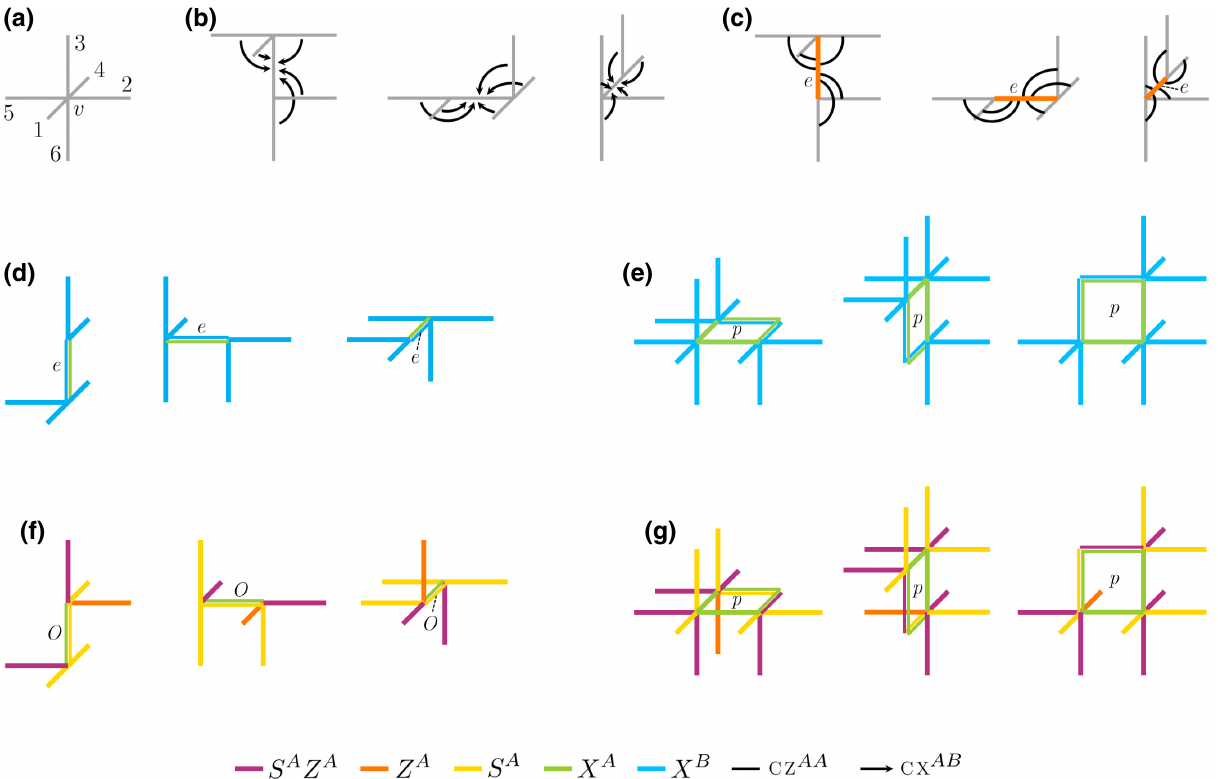
(cid:5) v U v . For a given edge, (cid:5) and (e) under U . (f) The operator ˆ F 0 , X A e e p e ∈ p . Each operator is a product of single-qubit and two-qubit gates over the p